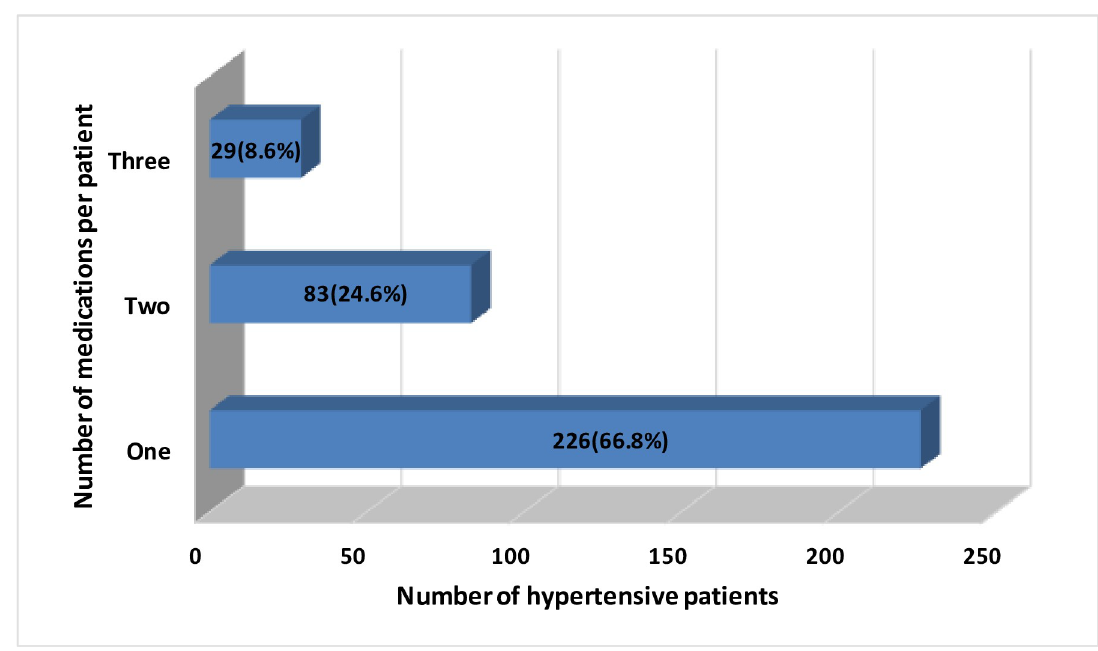
Fig 1. Number of antihypertensive medications used among adult ambulatory hypertensive patients in Mekelle Hospital, 2019.